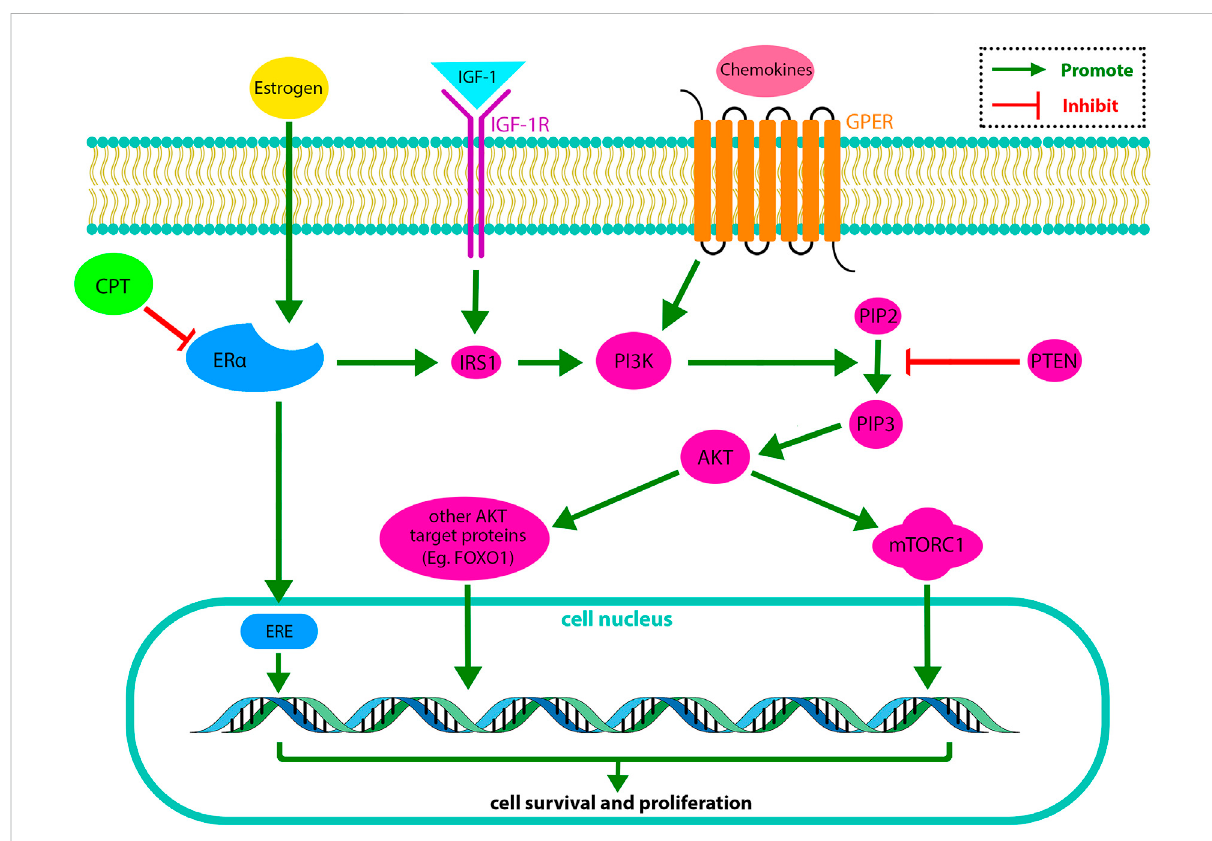
FIGURE 1 In the PI3K/AKT/mTOR pathway, IGF-1 activates IGF-1R, and some cytokines activate GPER in the cell membrane. IGF-1R and GPER activate PI3K. The activated PI3K has a catalytic effect on the phosphorylation of PIP2 to produce PIP3. PIP3 drives AKT. The activated AKT phosphorylates target proteins in thecytoplasmic fl uidand cell nucleus. Finally, phosphorylation ofAKT target proteins regulatescell survival and replication. Onthe otherhand,PTEN(aPIP3phosphatase)changesPIP3toPIP2,suppressingthePI3K/AKT/mTORpathway.TheER α isanotherreceptor,activating PI3K through stimulating IRS1. CPT exerts its inhibitory effect on the PI3K/AKT/mTOR pathway by inhibiting ER α (Miricescu et al., 2020). IGF-1 , insulin-likegrowthfactor1; IGF-1R ,insulin-likegrowthfactorreceptor1; GPER ,Gprotein-coupledreceptor; IRS1 ,Insulinreceptorsubstrate1; PI3K , Phosphatidylinositol 3-Kinase; PIP2 , Phosphatidylinositol (4,5)-bisphosphate; PIP3 , phosphatidylinositol (3,4,5)-trisphosphate; PTEN , phosphatase and tensin homolog; AKT , serine/threonine proteinkinase; mTORC , mammalian Target of Rapamycin complex; FOXO1 , Forkheadbox other 1; ERE , estrogen-responsive